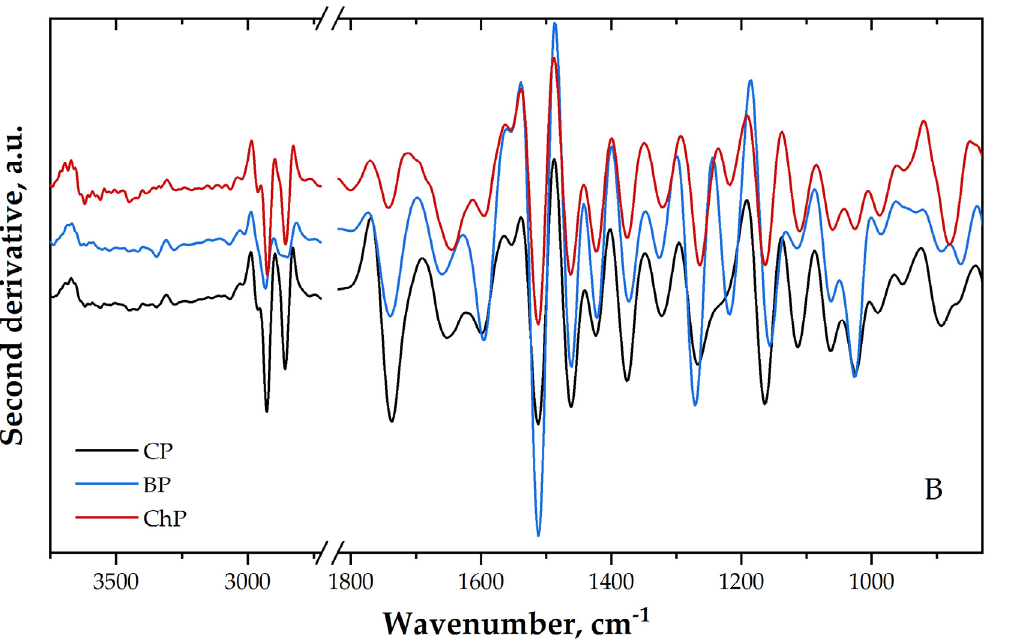
Figure 1. Infrared spectra ( A ) and their second derivatives ( B ); CP—contemporary sound pine, BP—biologically degraded pine, ChP—chemically degraded pine.